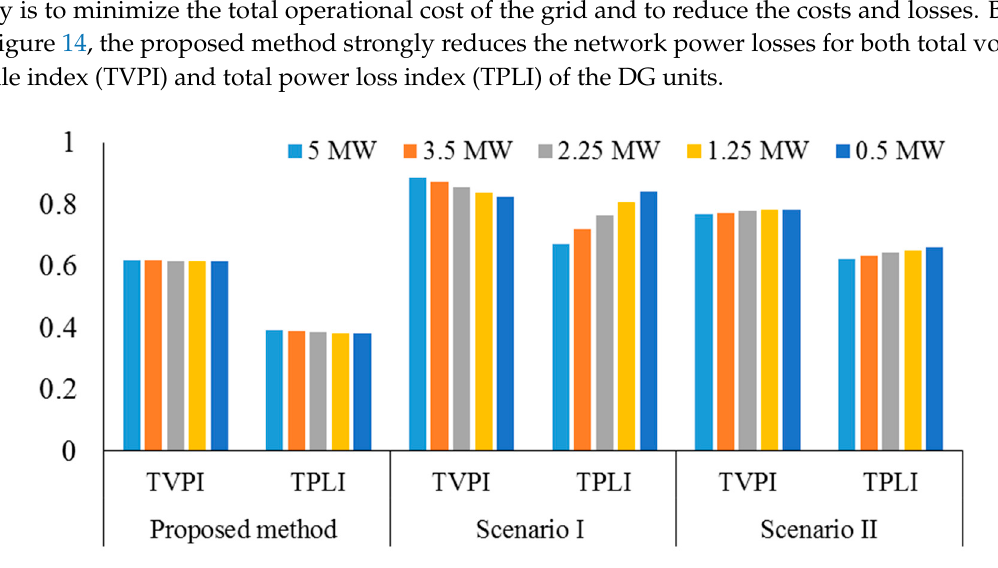
Figure 14. Results for the study by Ameli (2017) [80].